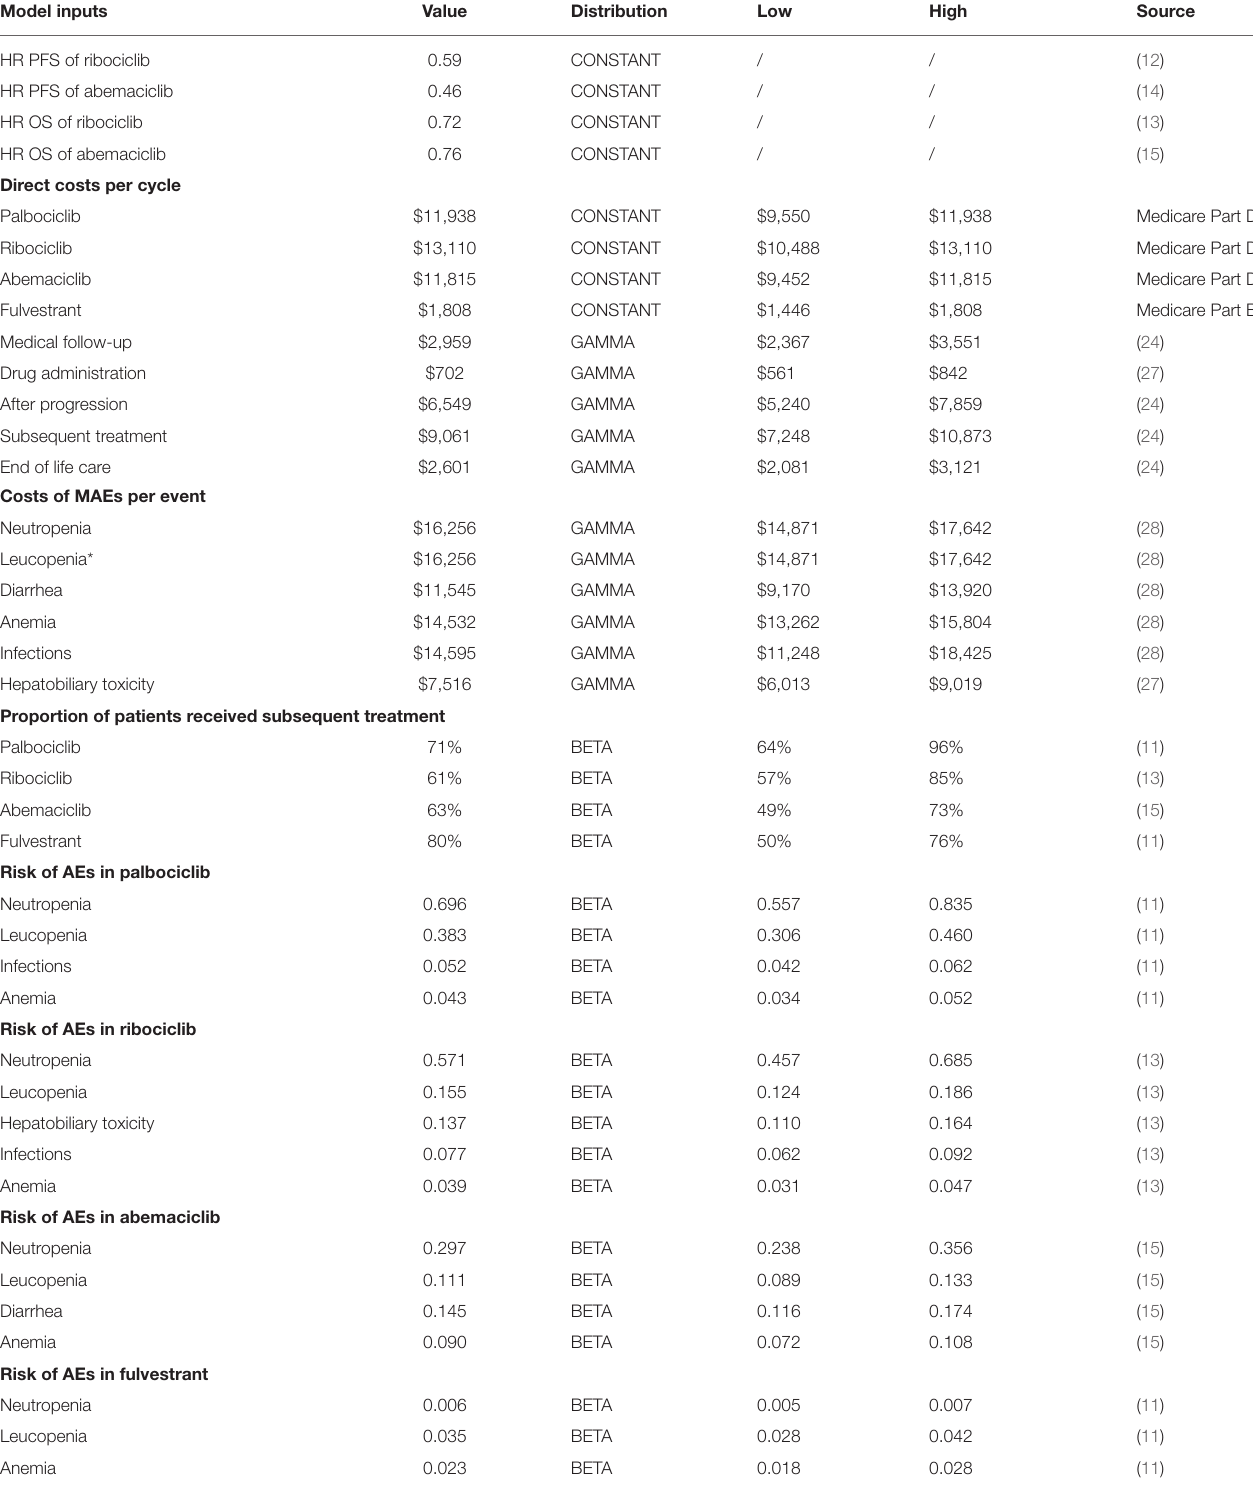
TABLE 1 | Overview of all model